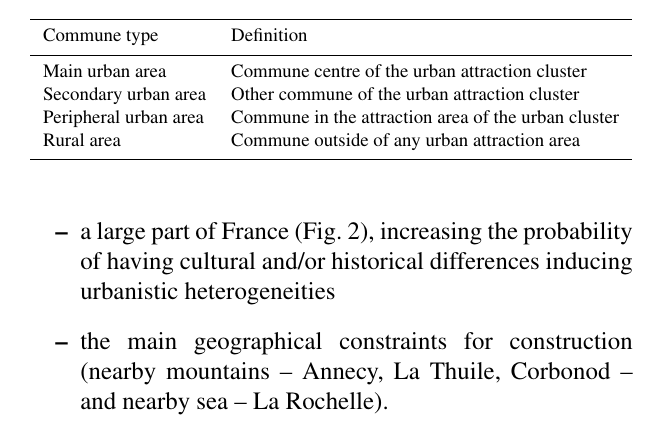
Table 1. The four commune types defined by INSEE